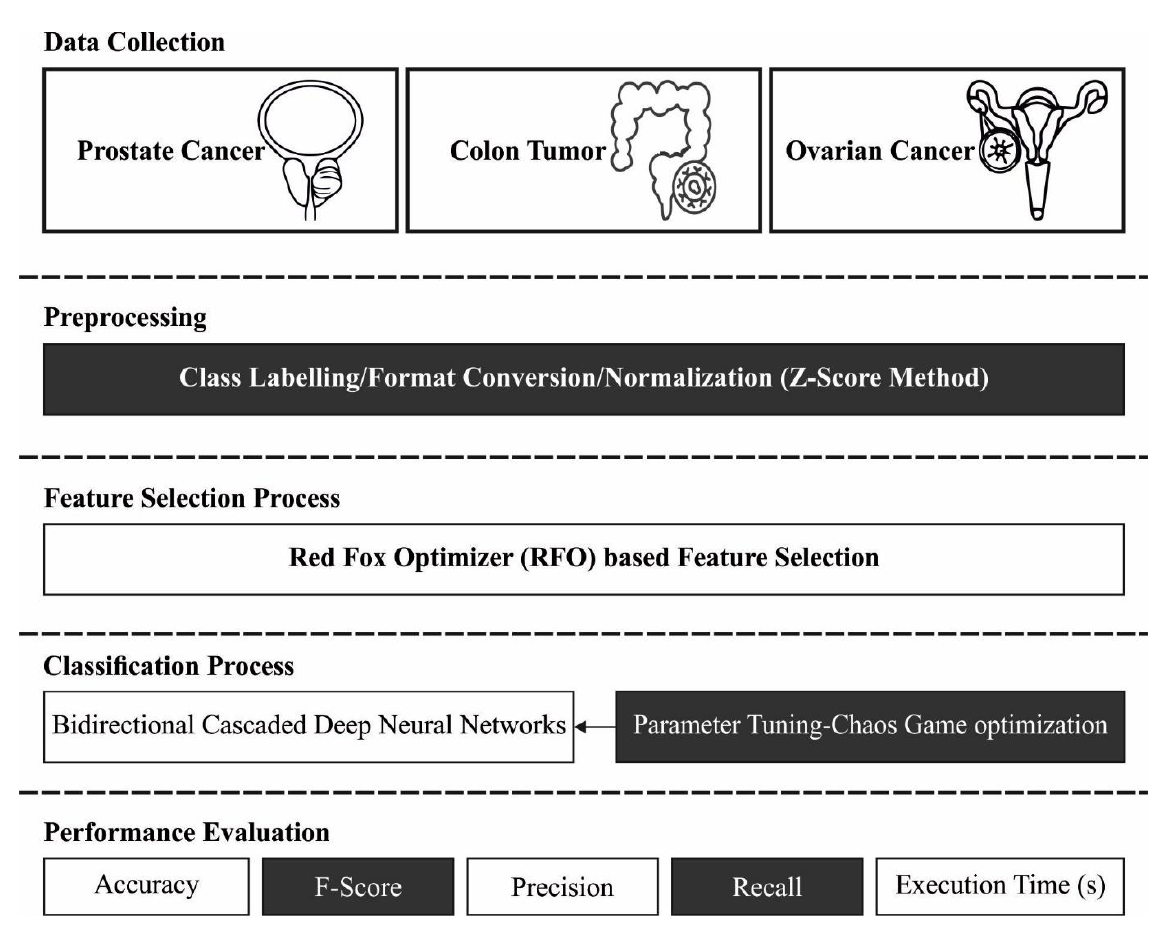
Figure 1. Block diagram of RFODL-MGEC technique.